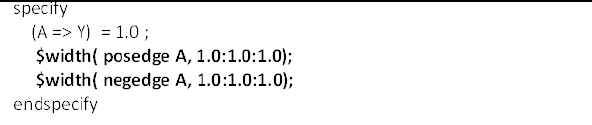
Figure 5. Delay chain composition